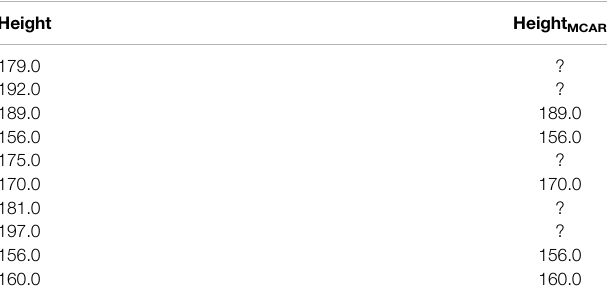
TABLE3| IntheMARcondition, height valuesarediscardeddependentonvalues in another column, here gender . All discarded height values correspond to rows in which gender was male .